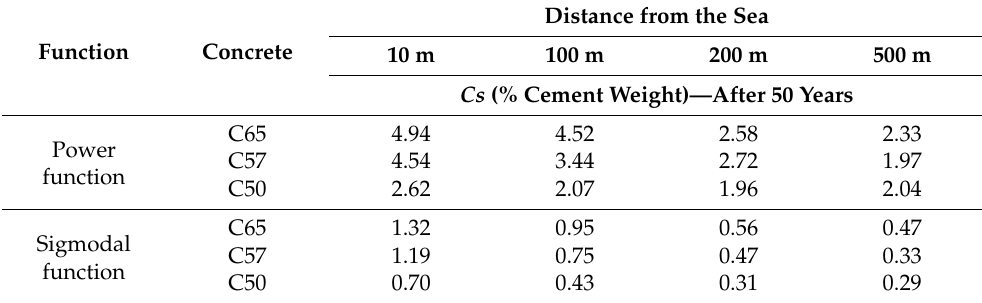
Table 4. Simulation of Cs values using power and sigmoidal functions for 50 years of exposure. Function